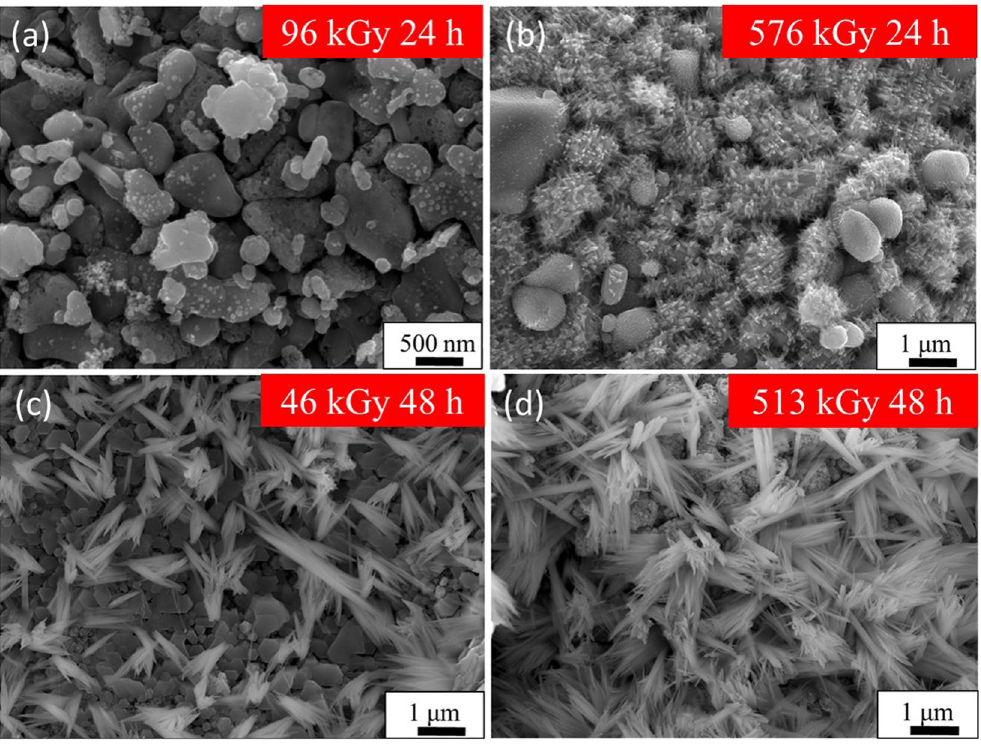
Figure 8. Gamma-ray irradiated substrates. FE-SEM images of the sample surface after gamma-rays irradiation at different fluences (96–576 kGy) and time (24 or 48 hours).